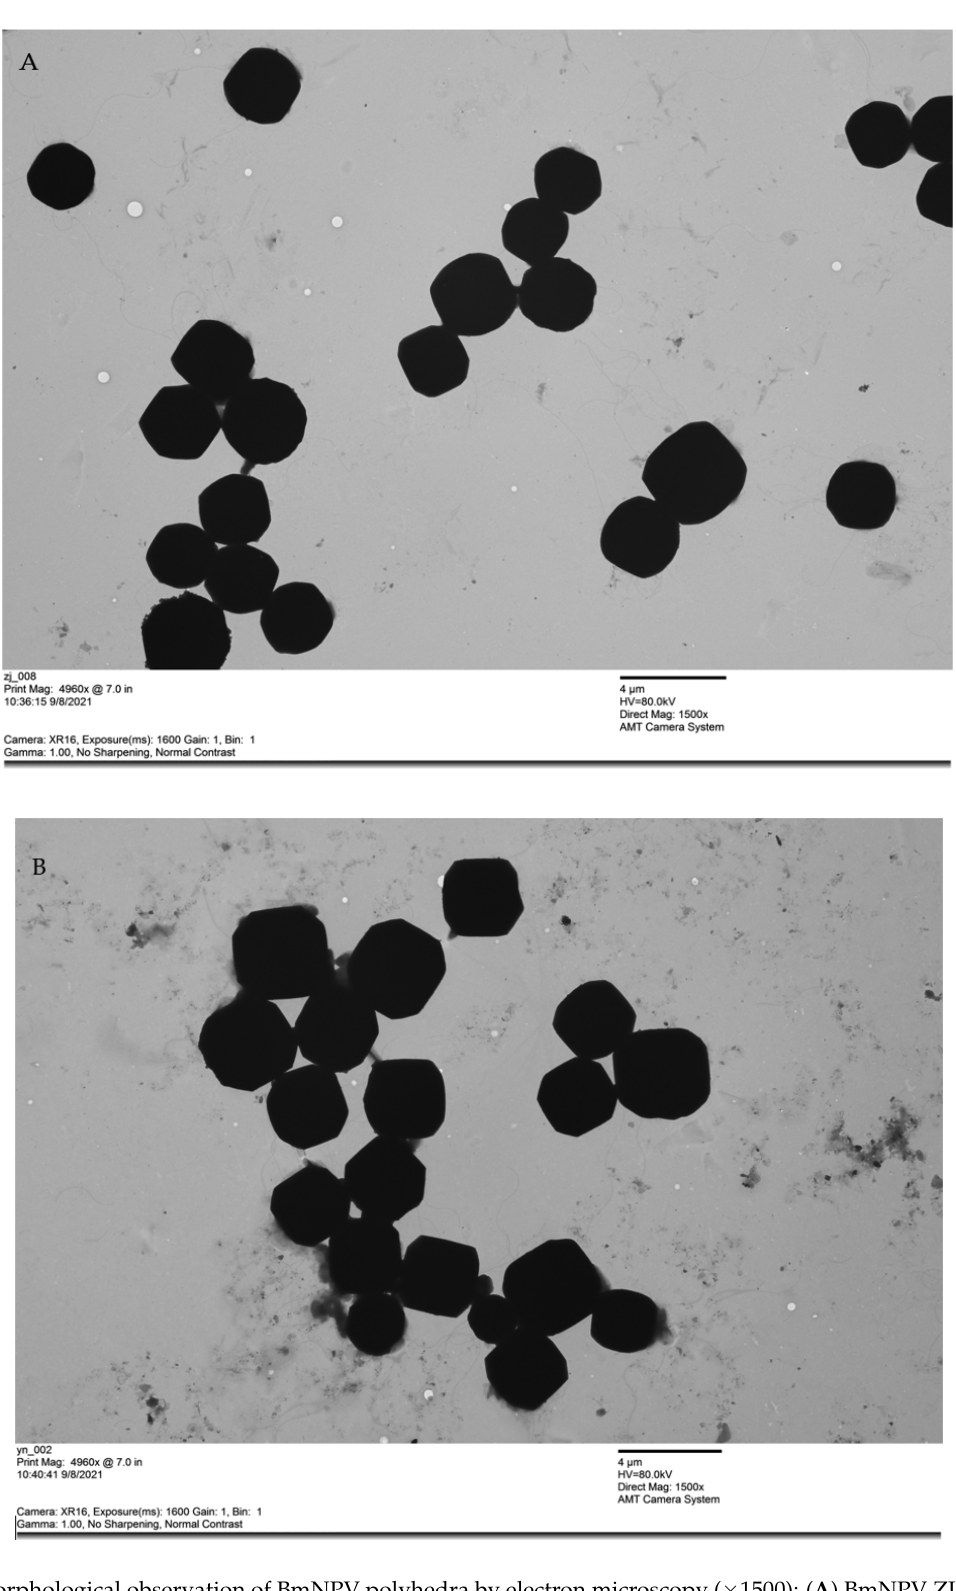
Figure 2. Morphological observation of BmNPV polyhedra by electron microscopy ( × 1500): ( A ) BmNPV ZJ and ( B ) Bm- NPV